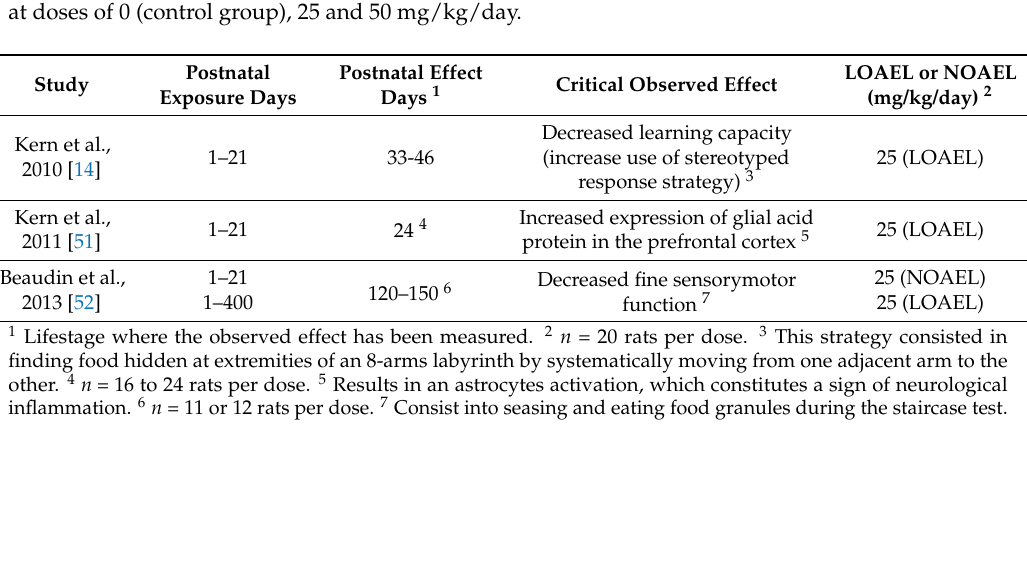
Table 2. Summary of the neurological effects observed in rats exposed orally to Mn following birth, at doses of 0 (control group), 25 and 50